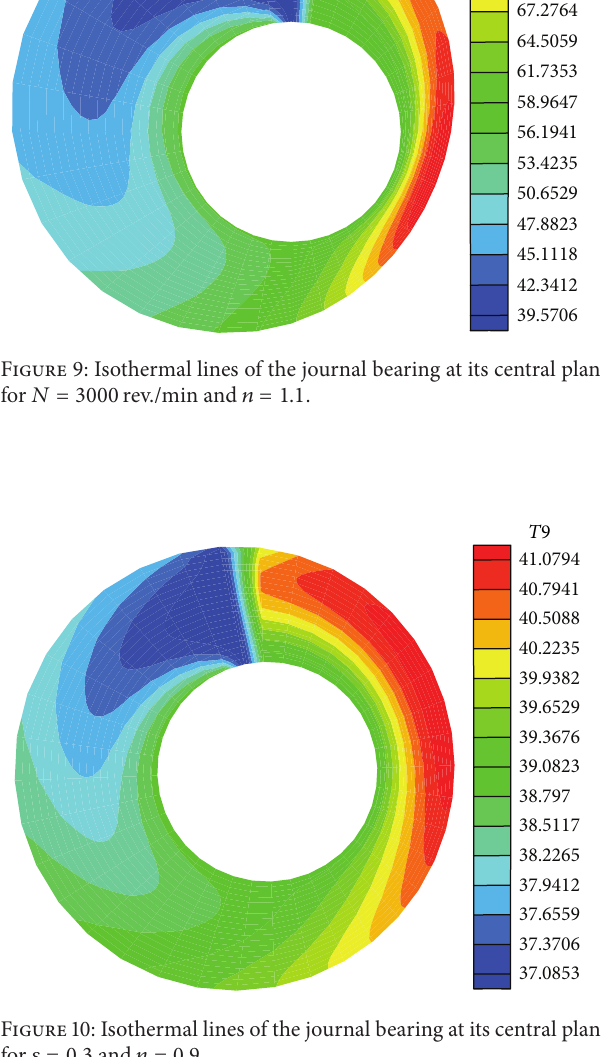
Figure 8: Isothermal lines of the journal bearing at its central plan for 𝑁 = 1000 rev./min and 𝑛 = 1.1 .